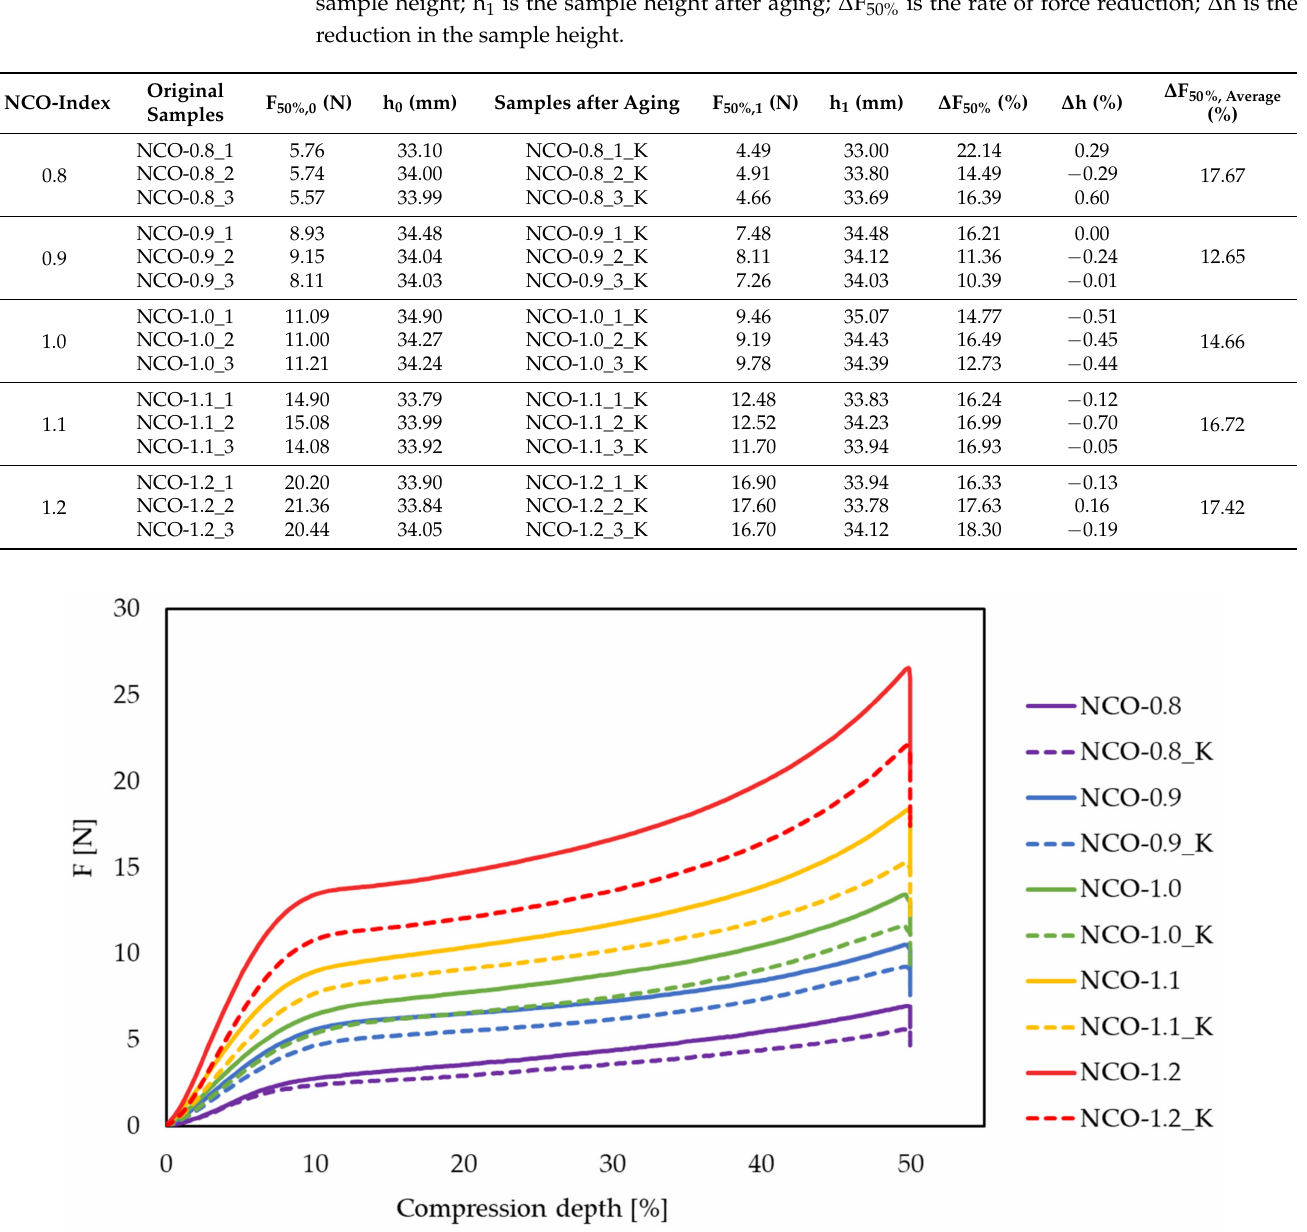
Figure 2. Average compression force (F) deflection curves measured before and after aging. The NCO-index of the samples varied from 0.8 to 1.2. The average curves of the samples after dry heat aging are marked with K (e.g.,